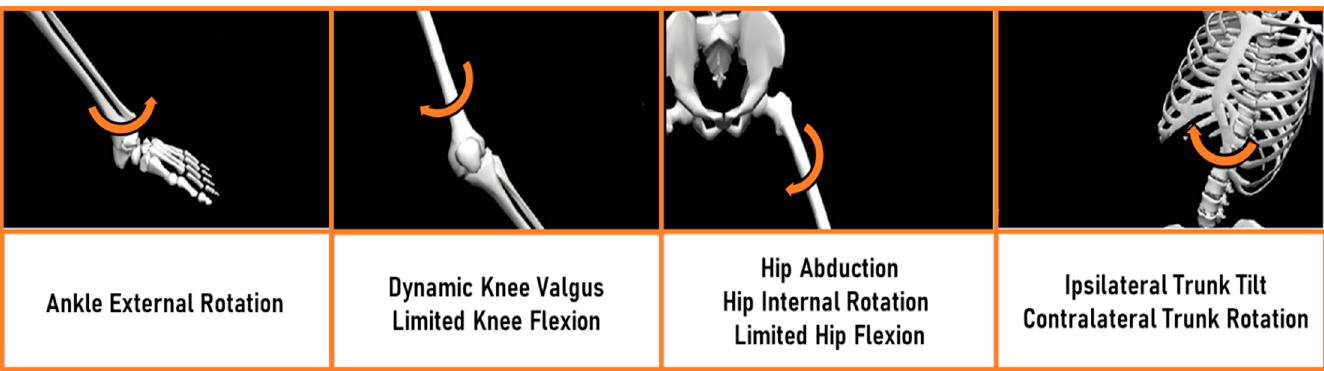
Figure 2. Common ACL injury mechanism according to the current literature. From the left: ankle, knee, hip, and trunk joint main kinematical mechanisms found in ACL injury. Arrows indicate the direction of joint motion. The limitation of these patterns is the goal of targeted neuromuscular training in rehabilitation after ACL injury. The figure is adapted from Della Villa et al. [1].